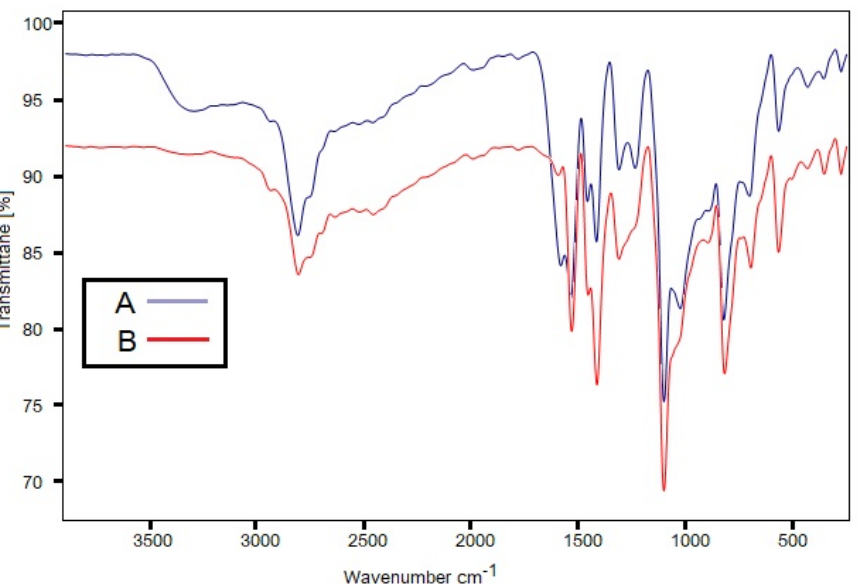
Figure 4. Fourier transform infrared (FTIR) spectrum of ( A ) pure ITN and ( B ) equilibrated ITN obtained from MeOH.